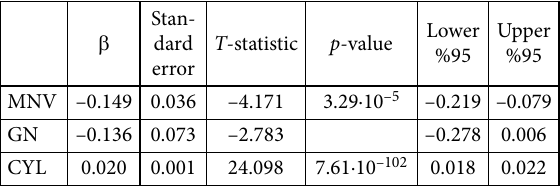
Table 8. Multiple regression statistics of manager type,